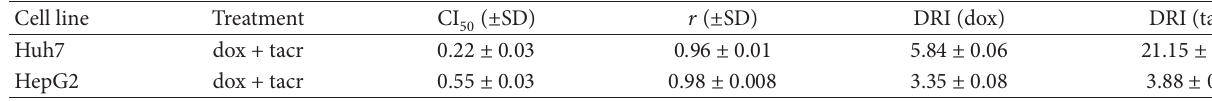
Table 1: Doxorubicin and tacrolimus cotreatment induced a synergistic antiproliferative effect compared to treatment with drugs administered individually as demonstrated by median drug effect analysis calculating the combination index (CI) and the dose redaction index (DRI) with CalcuSyn software. “ 𝑟 ” is the linear correlation coefficient.